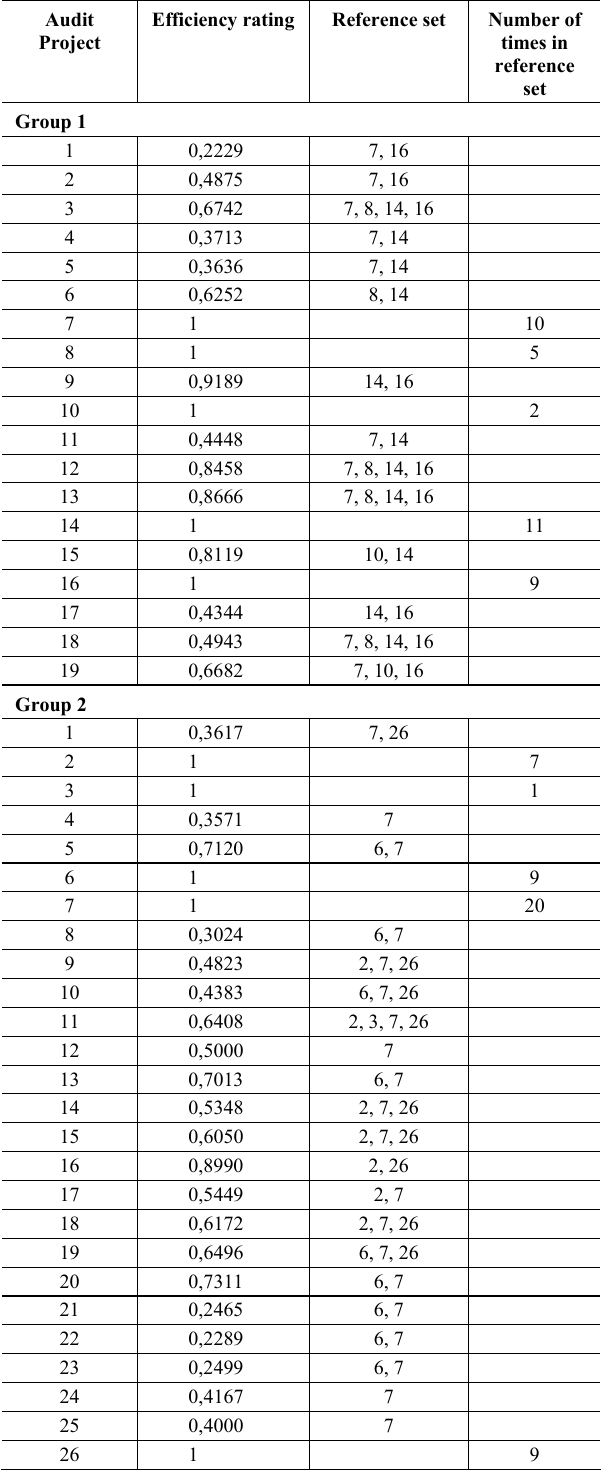
Table 2: Audit project efficiency ratings Audit